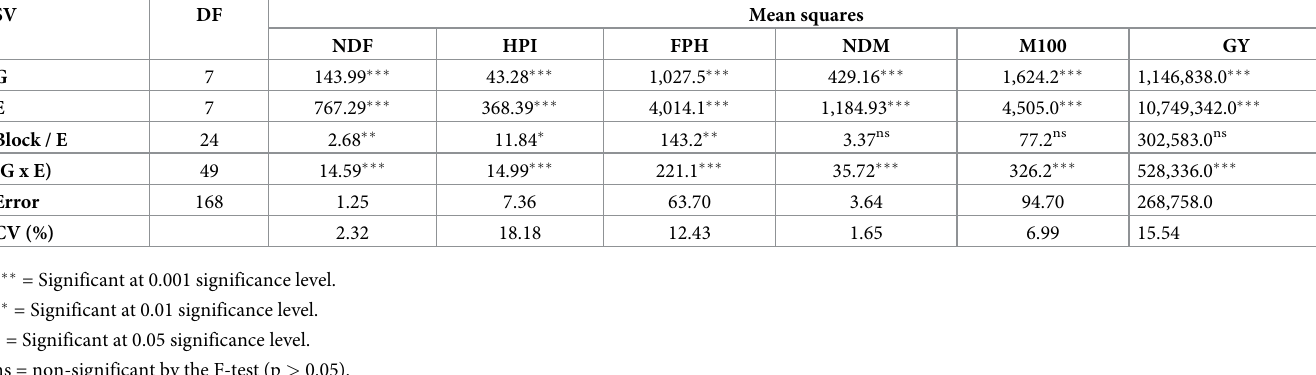
Table 2. Summary of the joint analysis of variance for number of days to flowering (NDF), height of first pod insertion (HPI), final plant height (FPH), number of days to maturity (NDM), mass of 100 grains (M100), and grain yield